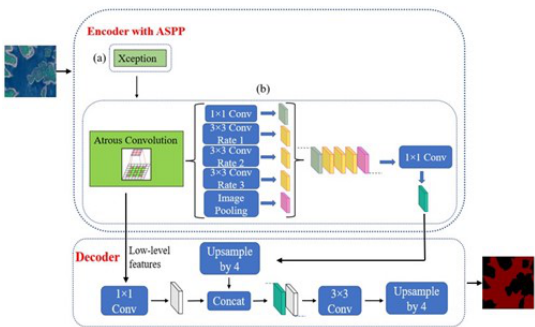
Figure 1. Overview of DeepLabv3+ Architecture – Consisting of Encoder-Decoder with Atrous Spatial Pyramid Pooling. (a) Xception is the Encoder for generating features. (b) Atrous spatial pyramid pooling in which atrous convolution is employed at multiple rates on the features generated by the encoder. Decoder is to upsample the relevant features generated by